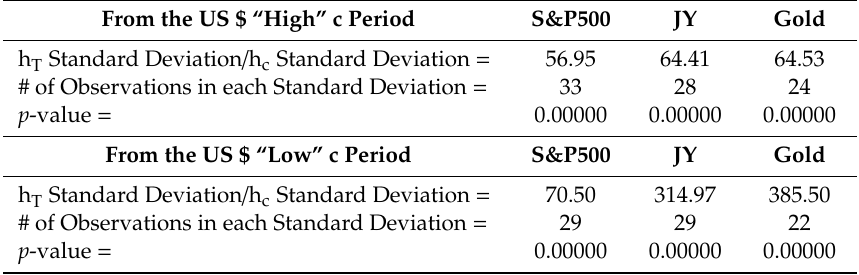
Table 2. h T Standard Deviation / h c Standard Deviation (HRs based on US